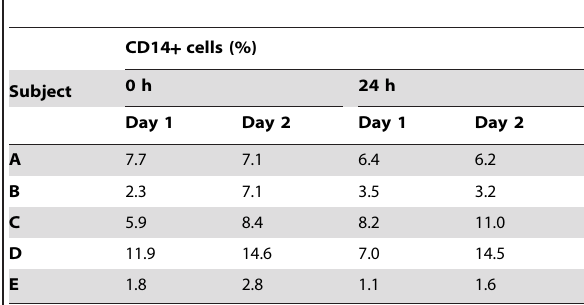
Table 3. Proportion of monocytes (CD14 + ) in different